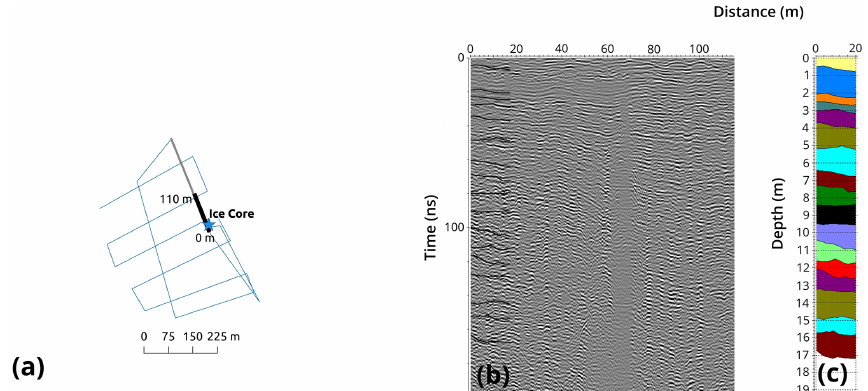
Figure 5. Young Island GPR. (a) Reference map depicts the full track of measurements (blue), the profile (grey), and the section shown in the radargram (black). (b) Section of a radargram obtained walking in NW direction from the ice core, shown with layer interpretation and (c) estimated depth of layers. A crevasse was detected at 70m from the starting point (discontinuity in the reflections).